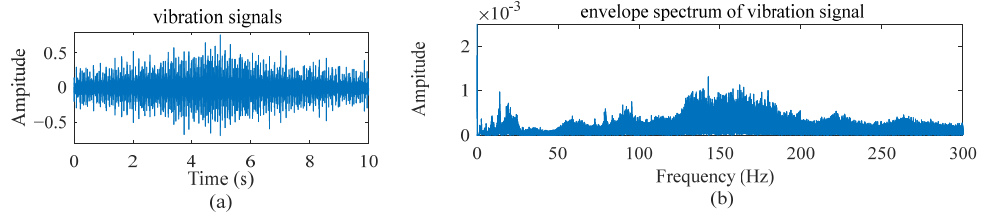
Figure 2. Vibration signal and its envelope spectrum under speed increasing and then decreasing working conditions when an inner raceway fault occurs.